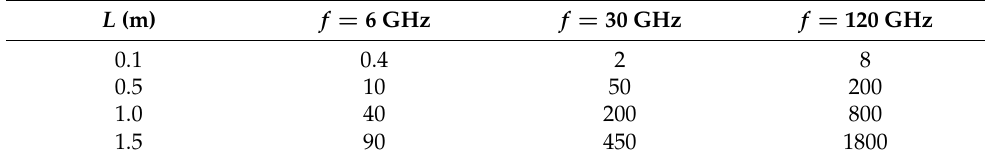
Table 1. Antenna near-field distances D (m).